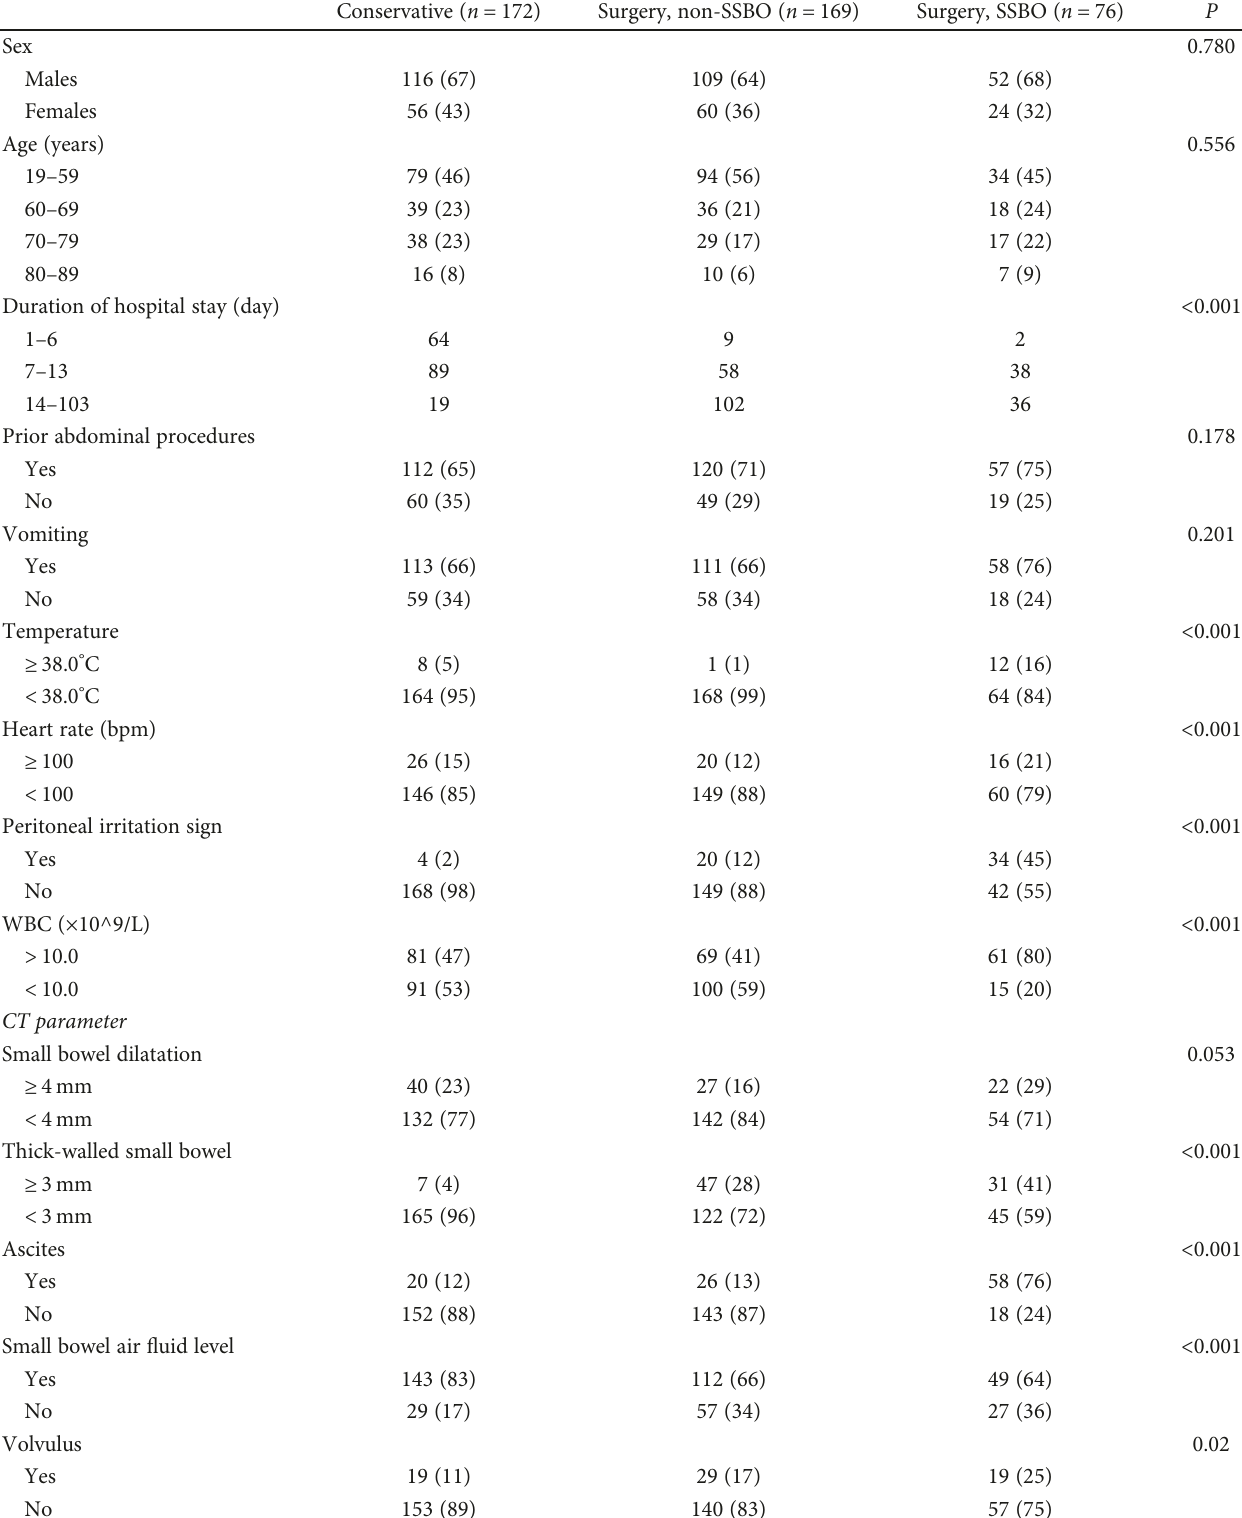
Values in parentheses are percentages. CT: computed tomography; SSBO: strangulated small bowel